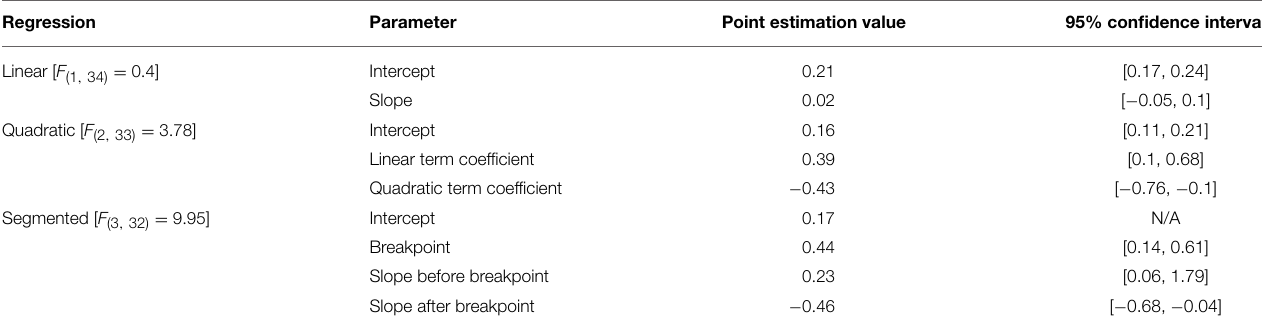
TABLE 2 | The 95% confidence intervals for parameters of the regression analyses for the correlation of the Raven items with WMC (calculated from the three complex span tasks; N = 347 ) over difficulty of the items. Regression Parameter Linear [ F (1 , 34) 0 . 4 ] =